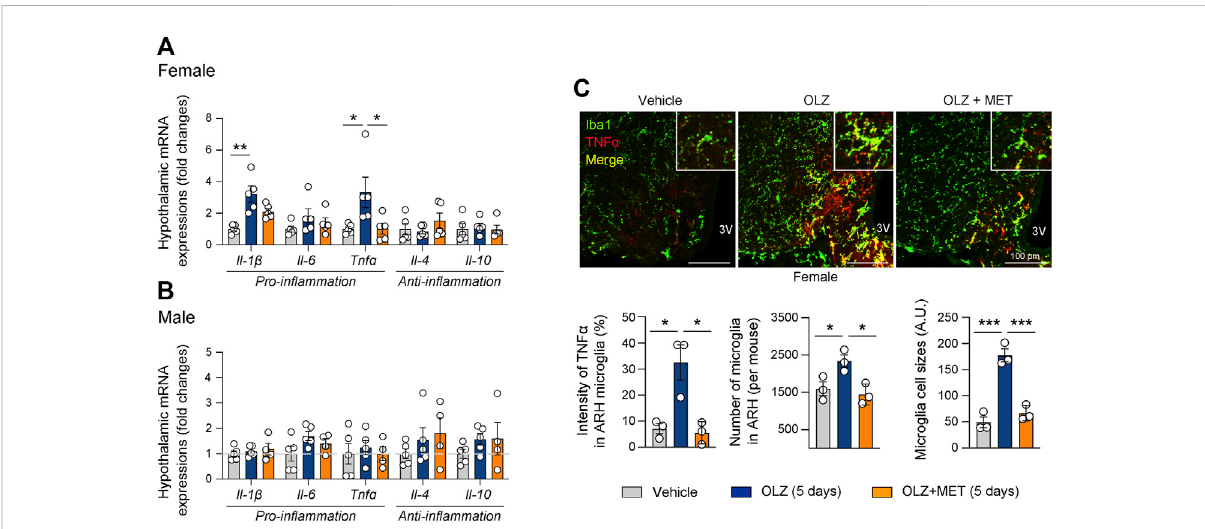
FIGURE 3 Metformin (MET) attenuates olanzapine (OLZ)-induced microglial activation and in fl ammation in the hypothalamus. (A,B) Effect of OLZ or OLZ + MET administration on the hypothalamic mRNA expression of Il-1 β , Il-6 , Tnf α , Il-4 , and Il-10 in female and male mice ( n = 4 – 5). (C) Representative images of Iba1 and TNF α expression in ARH ( n = 3). Data are presented as mean ± SEM values. Statistical analyses were performed using one-sided one-way analysis of variance (ANOVA) followed by a post hoc least signi fi cant difference (LSD) test. * p < 0.05, ** p < 0.01, and *** p < 0.001 between the indicated groups. Scale bars: 100 μ m.